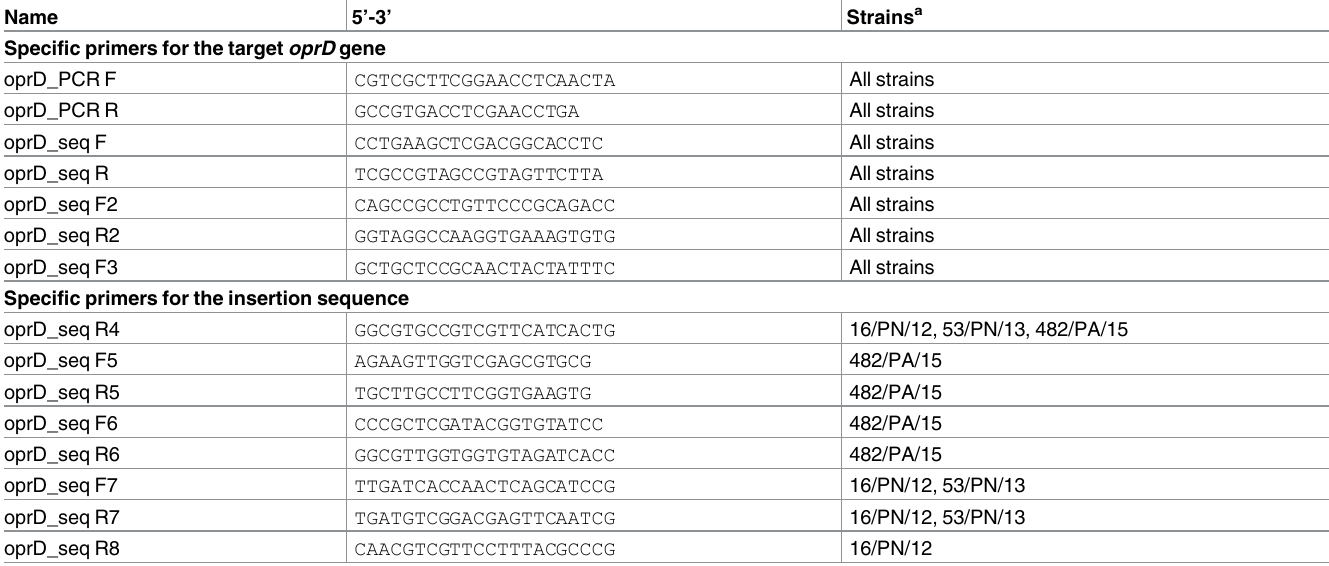
Table 1. Primers used for